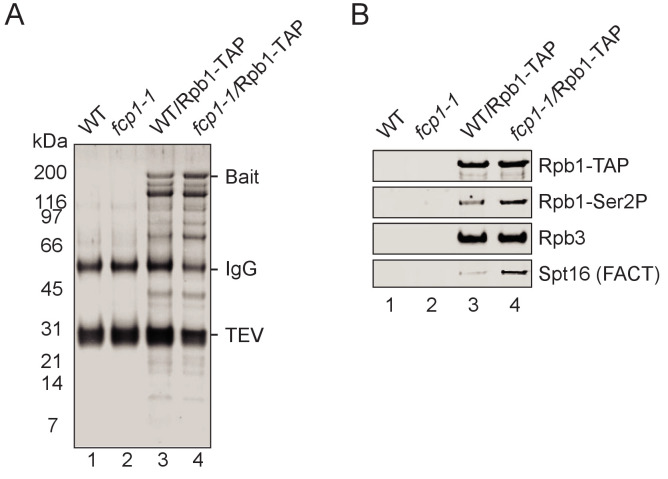
Rpb1-TAP complexes purified from WT and fcp1-1 cells.(A) A silver-stained SDS-PAGE gel showing RNAPII complexes purified from WT and fcp1-1 cells. Lanes 1 and 2 are control purifications from cells non-expressing Rpb1-TAP protein. The bait (Rpb1-TAP), the IgG (from the beads used to purify the complexes), and the TEV (used to cleave within the TAP-tag and eluate the complexes from the beads) are indicated. (B) Western blot showing Rpb1, Rpb1-Ser2P, Rpb3, and Spt16 in RNAPII complexes purified from WT and fcp1-1 cells. Lanes 1 and 2 are control purifications from cells non-expressing Rpb1-TAP protein.